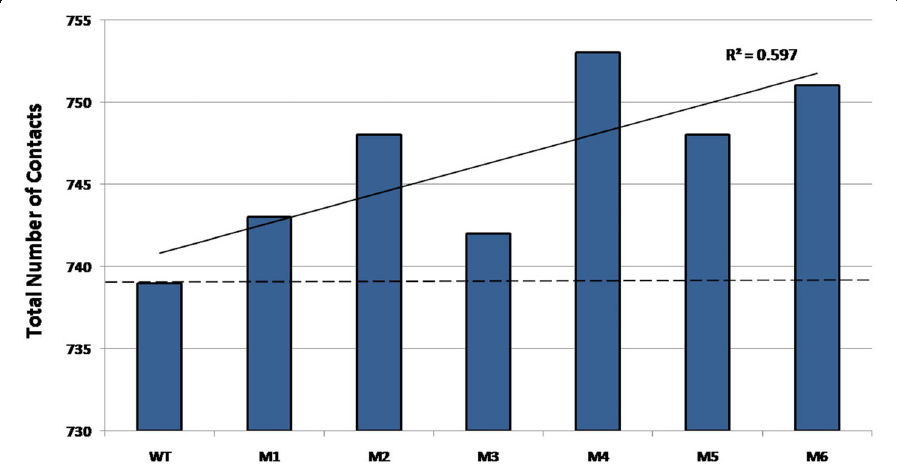
Fig. 4 Total number of contacts (edges) in the PCNs of the WT and mutant Lipase A. The trend line shows an increasing tendency with coefficient of determination R 2 ~